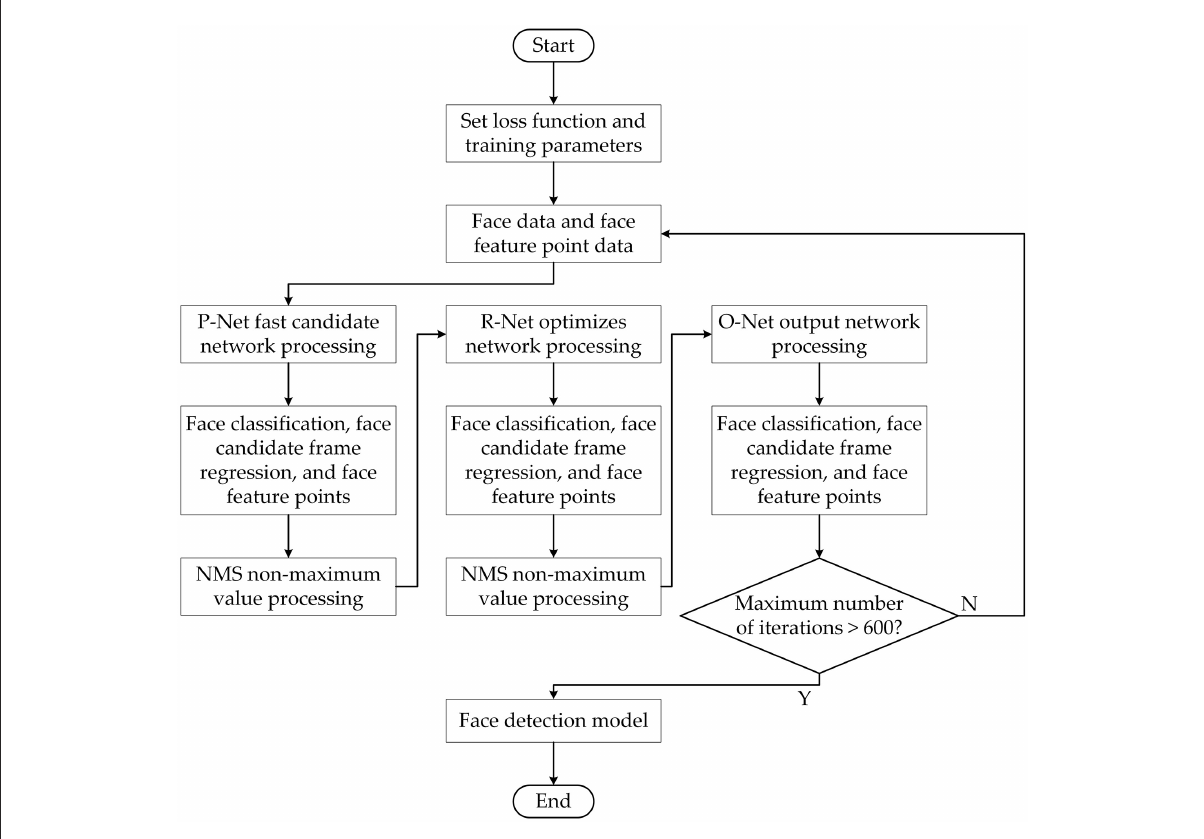
FIGURE6 Training process of improved MTCNN.